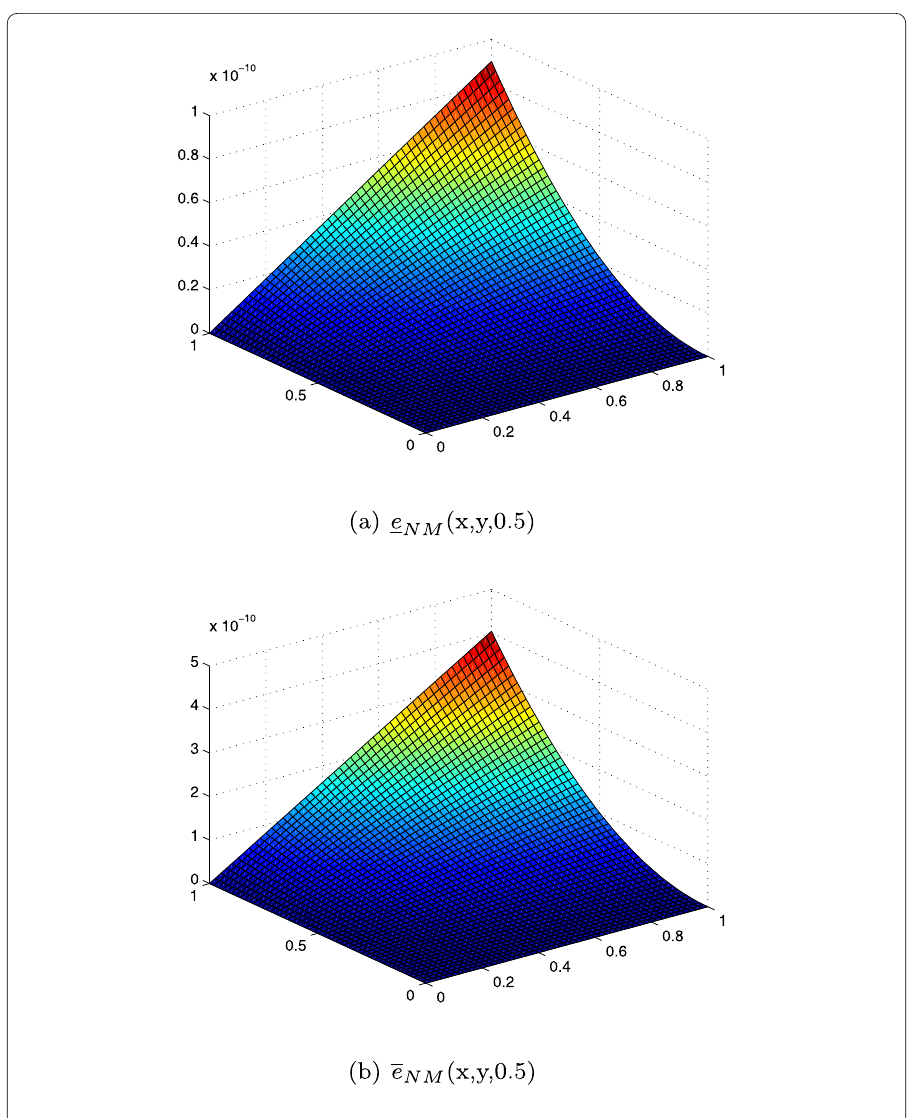
Figure 1 Numerical errors with N = 10 of Example 5.1